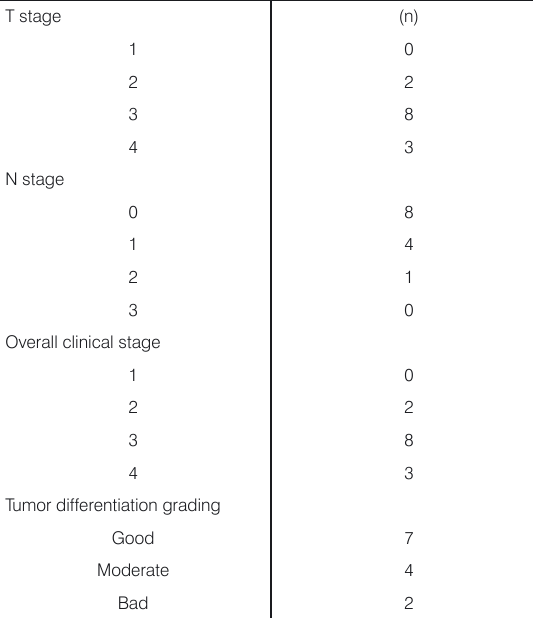
Table 1. Pathologic staging of the patients